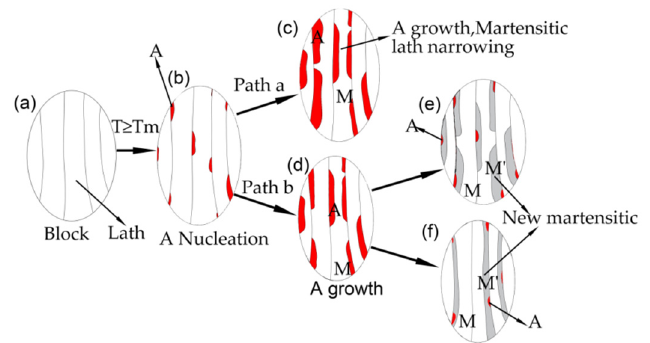
Figure 14. Refinement diagram of martensite lath. ( a ) is block; ( b ) is reversed austenite nucleation; ( c ) is reversed austenite growth, martensitic lath narrowing; ( d ) is reversed austenite growth; ( e ) is reversed austenite is re-transformed into new martensite; ( f ) is wider Martensitic lath is divided into two pieces.